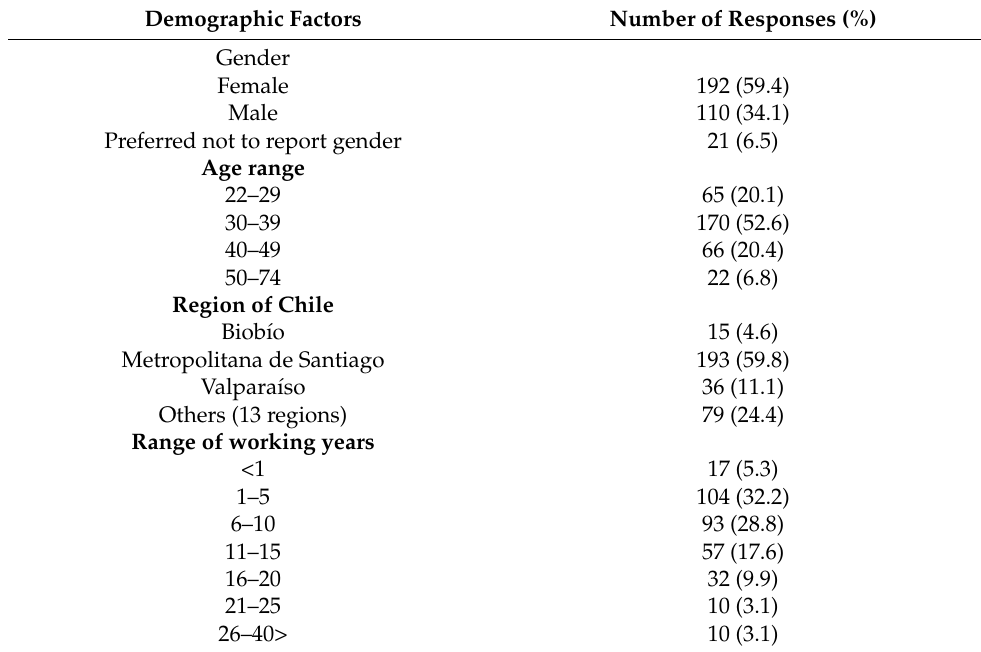
Table 1. Distribution of demographics of companion animal veterinarians ( n = 323) participating in an online survey to identify antimicrobial use practices in Chile,